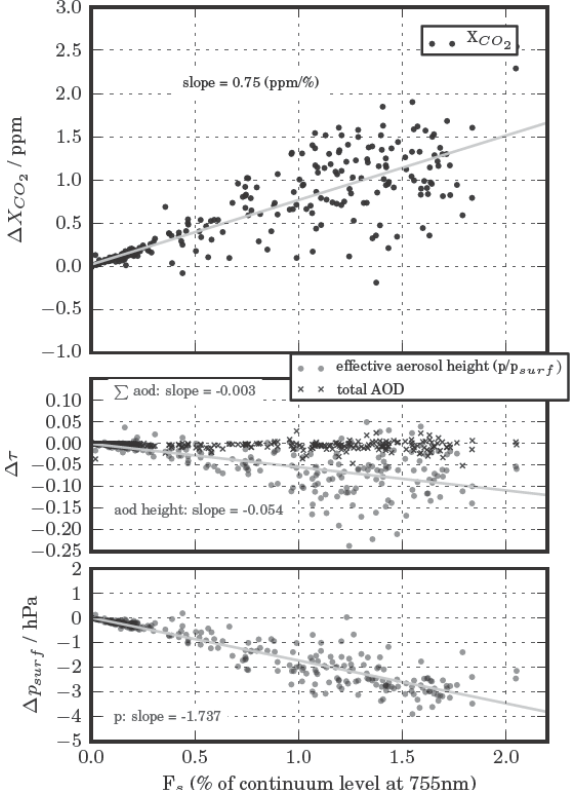
Fig. 4. Case #2a: Changes in retrieved X CO , retrieved aerosols as 2 well as surface pressure induced by chlorophyll fluorescence if it is ignored in the retrieval step. Simulations use a complex set of aerosol scenes, and the retrieval employs the ACOS/OCO-2 stan- dard retrieval setup, fitting for aerosols and surface pressure. Ef- fective aerosol height is defined in normalized pressure coordinates (fraction of surface pressure).